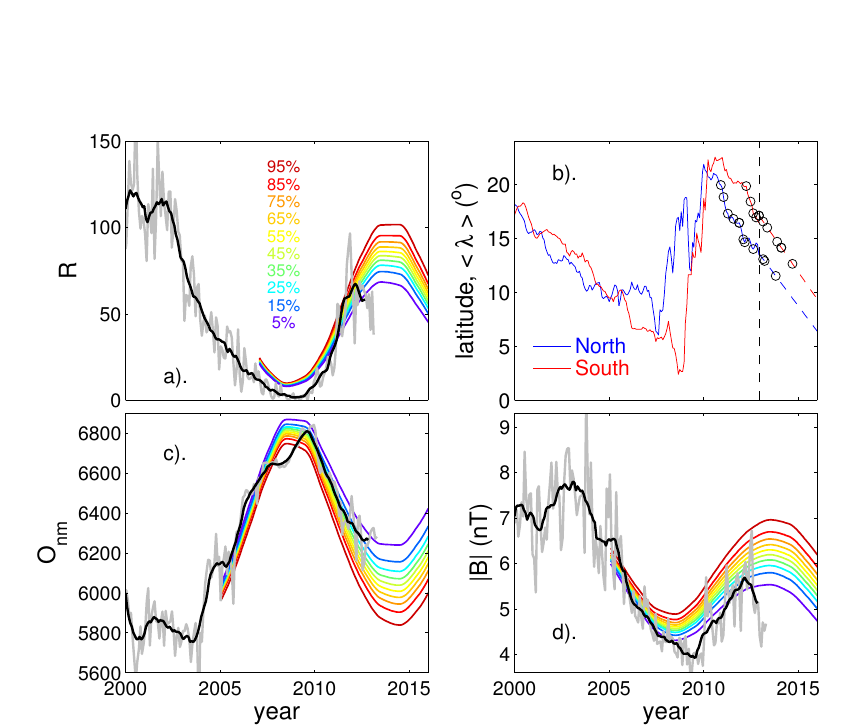
Figure 40: The evolution of solar cycle 24 thus far. Observed monthly means (in grey) and 12-point running means of monthly data (in black) of (a) sunspot number, 𝑅 ; (c) Oulu neutron monitor counts, 𝑂 nm and (d) the observed near-Earth IMF field strength, 𝐵 . In each of these plots the coloured lines are the predicted levels at various probabilities 𝑃 between 95% (in red) and 5% (in mauve), as derived by Barnard et al. (2011). The value shown is that which has a (100 − 𝑃 )% chance of being exceeded in the case of 𝑅 and 𝐵 and a 𝑃 % chance of being exceeded in the case of the comic ray counts. Panel (b) shows the monthly mean latitudes of sunspots groups ⟨ 𝜆 ⟩ . The red line is for the southern solar hemisphere, the blue for the north and solid line is observed whereas the dashed is a linear extrapolation of the cycle 24 behaviour into the future. The circles show the mean latitude for that hemisphere at which peak sunspot number was seen in cycles 12 – 23: the number of open circles to the right of the dashed line is the number of those cycles that had not yet reached their peak sunspot number in that hemisphere for the latest shown mean latitude of spots in that hemisphere. This plot will be updated regularly as the cycle progresses: this version was generated on 20 April